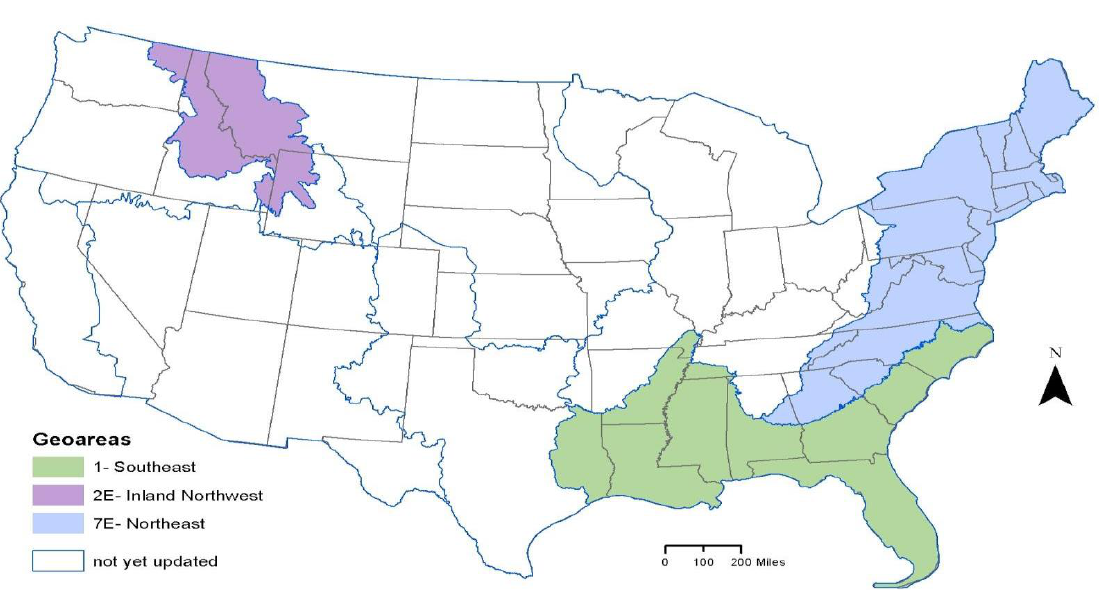
Figure 1. Geoareas with the three pilot project areas